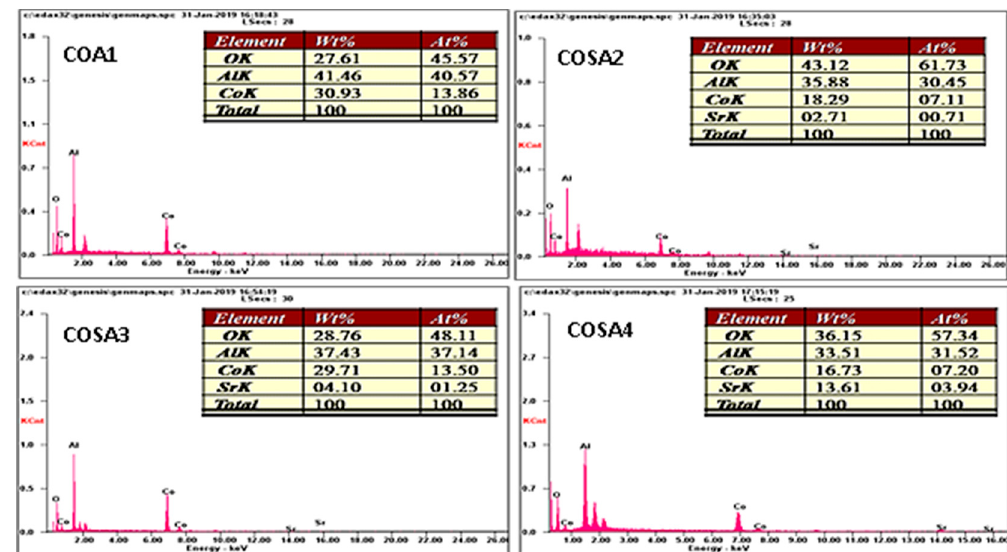
Figure 4. EDX spectra of Sr-doped CoAl 2 O 4 nanoparticles.